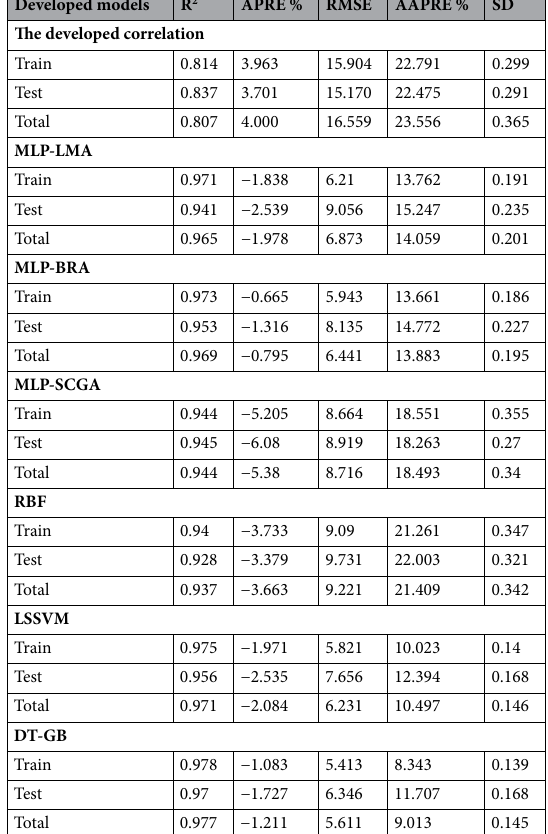
Table 4. Statistical error analysis of the developed models for the rate of